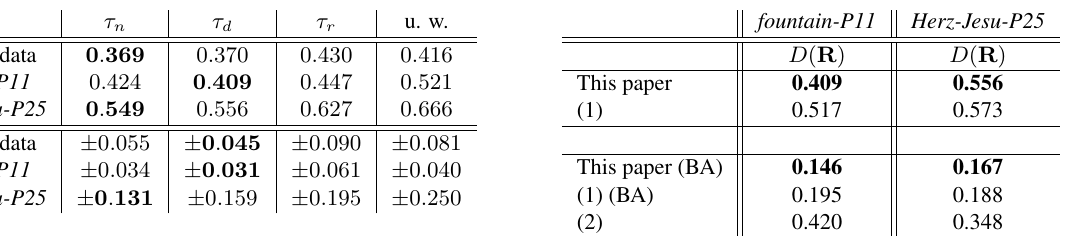
Figure 7: Visualisation of the orientation results of our approach on real image sequences, partly improved by a subsequent bundle adjustment (7b and 7d). The top row shows exemplary images.